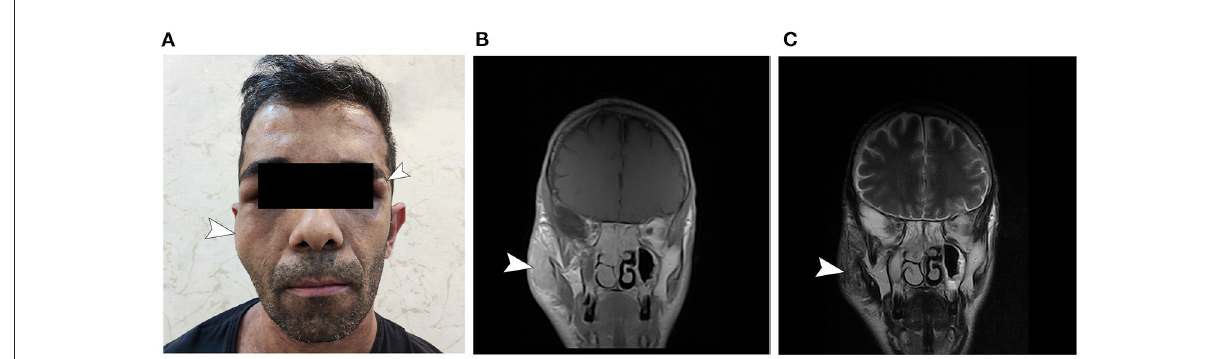
FIGURE1 General appearance of the patient. (A) Note the presumed neurofibroma of the right facial nerve and the neurofibroma in the left periorbital region. The patient had multiple café-au-lait spots on his abdomen and thorax (not shown). (B) T1 gadolinium-enhanced and (C) T2-weighted MRI sections corresponding to the right-side presumed facial neurofibroma.